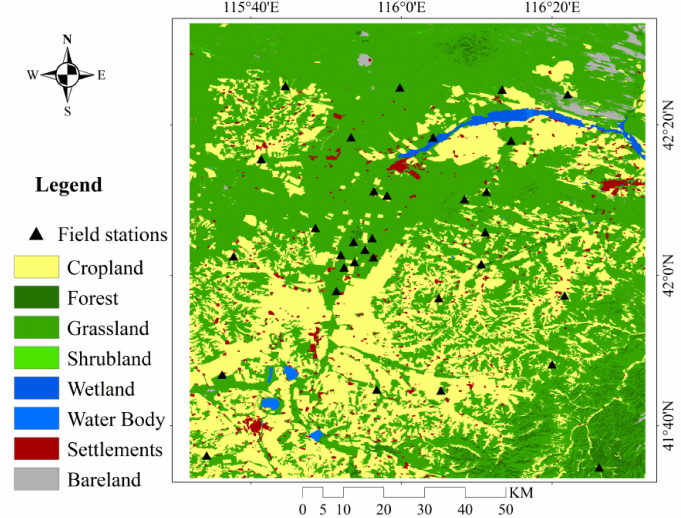
Figure 1. Location and land cover type of the study area; Locations of 34 SMN-SDR stations noted (solid triangle).